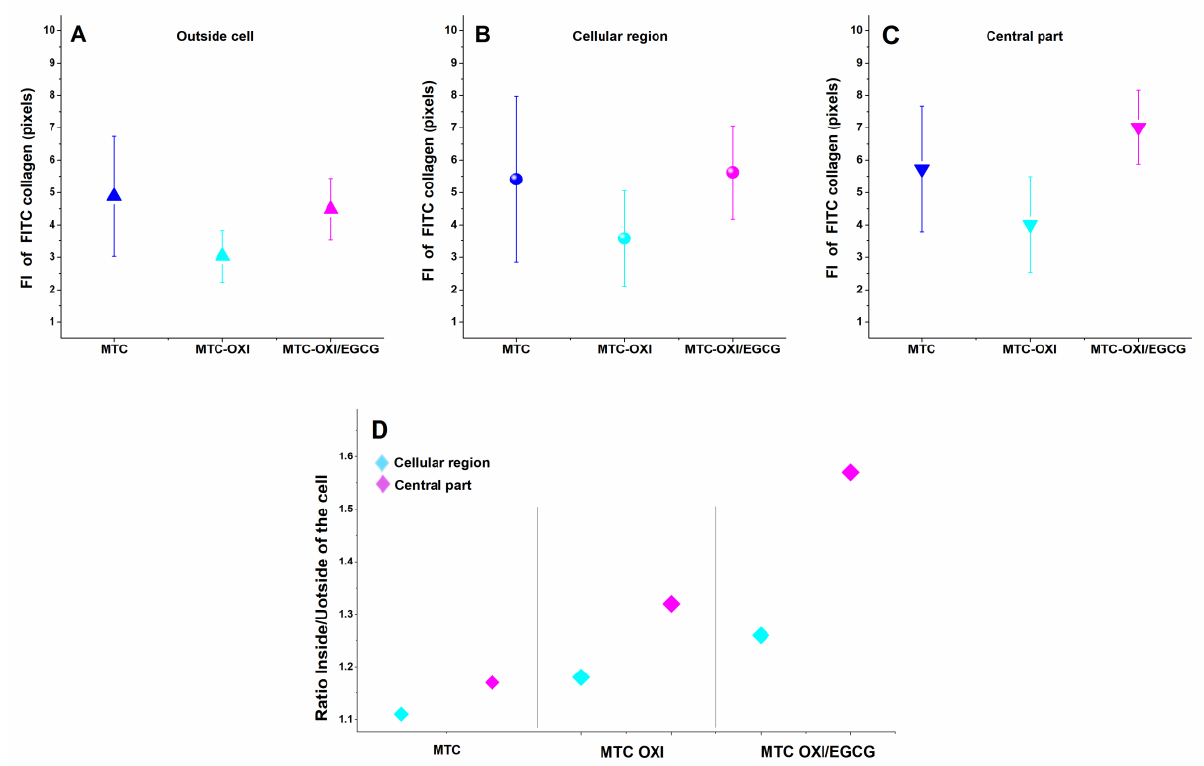
Figure 6. Fluorescence intensity (FI) in pixels of FITC collagen studied in different cell regions of interest (ROI): Outside the cells panel ( A ), the cellular region panel ( B ), and the central part—( C ). The native (MTC), oxidized (MTC-OXI), and EGCG pretreated (MTC-OXI/EGCG) collagen samples were measured and compared. The FI ratio for Cellular region and the central part versus outside the cells, as calculated for the same collagen samples presented on panel ( D ). Total anisotropy index (AI), for the whole sample, was measured for the bare collagen samples ( − cells) and for samples with cells (+cells), as shown in Figure 5A and in the first two rows of the Supplementary Table